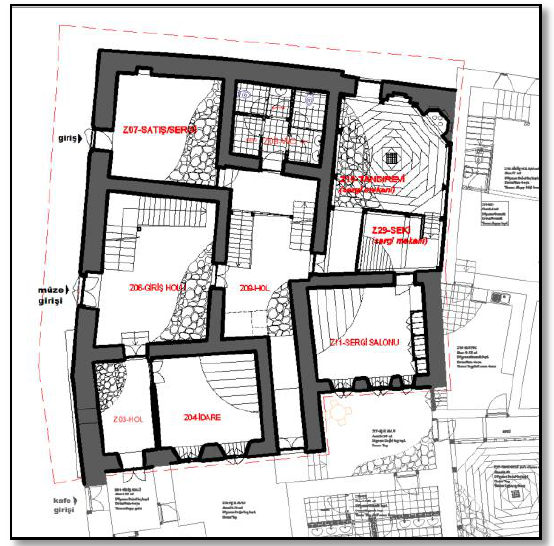
Figure 12. Restoration Project- Spaces of Museum Section Z03-Hall/ Z04-Administration (Management)